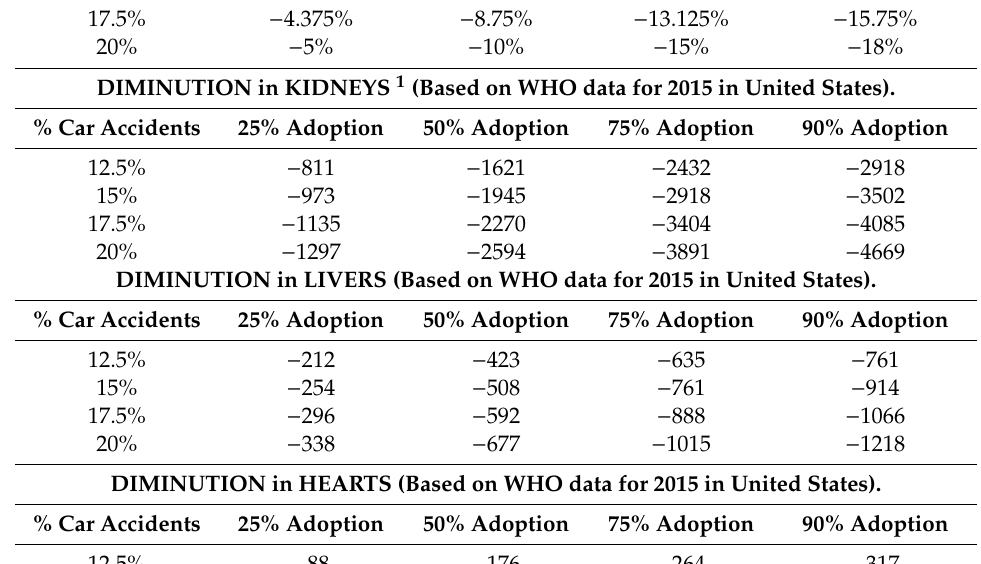
DIMINUTION in LUNGS (Based on WHO data for 2015 in United States). % Car Accidents